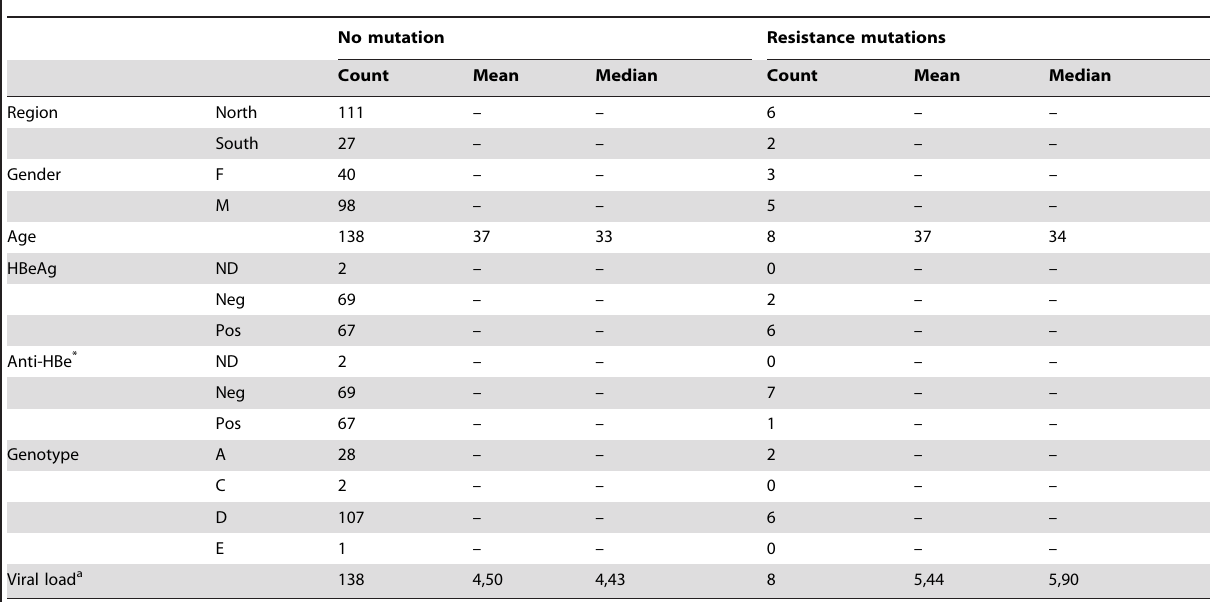
Table 5. Distribution of antiviral resistance mutations.